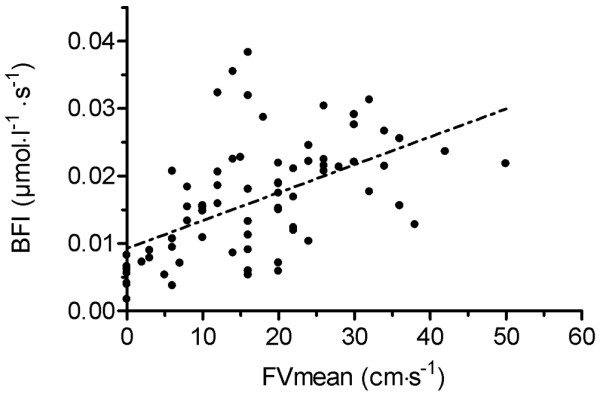
Correlation between blood flow velocity by transcranial Doppler ultrasound and blood flow index (BFI) by near infrared spectroscopy. FVmean, mean blood flow velocity in the right middle cerebral artery; r = 0.62; p < 0.0001. n = 76 measurements in 20 animals.